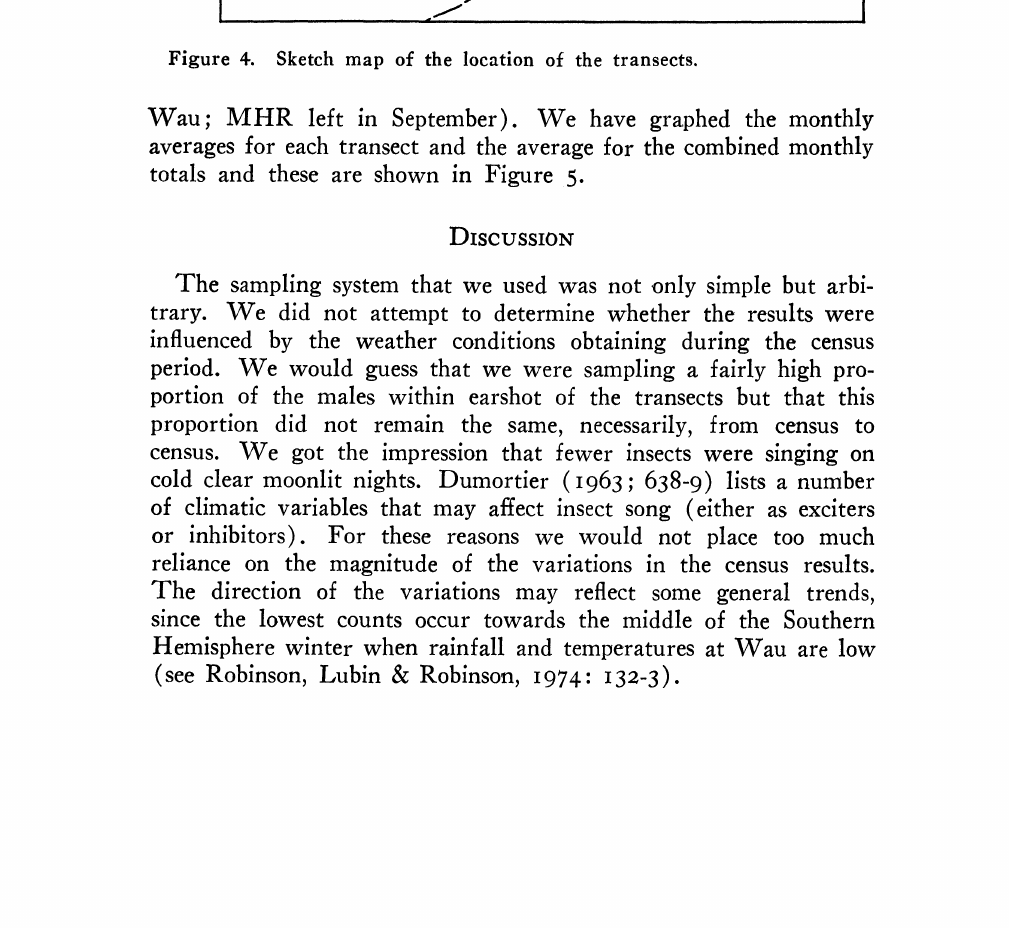
Figure 4. Sketch map ot the location ot the